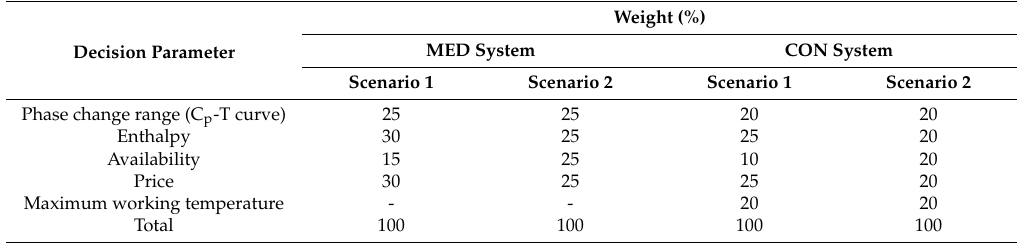
Table 2. Reference values of the